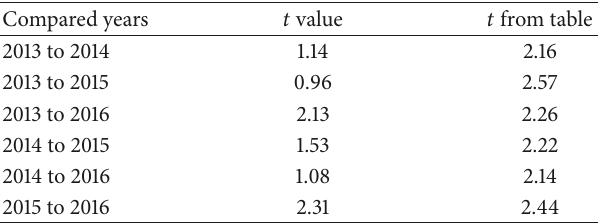
Table 3: Comparisons between linear regression equations using the 𝑡 -test method.